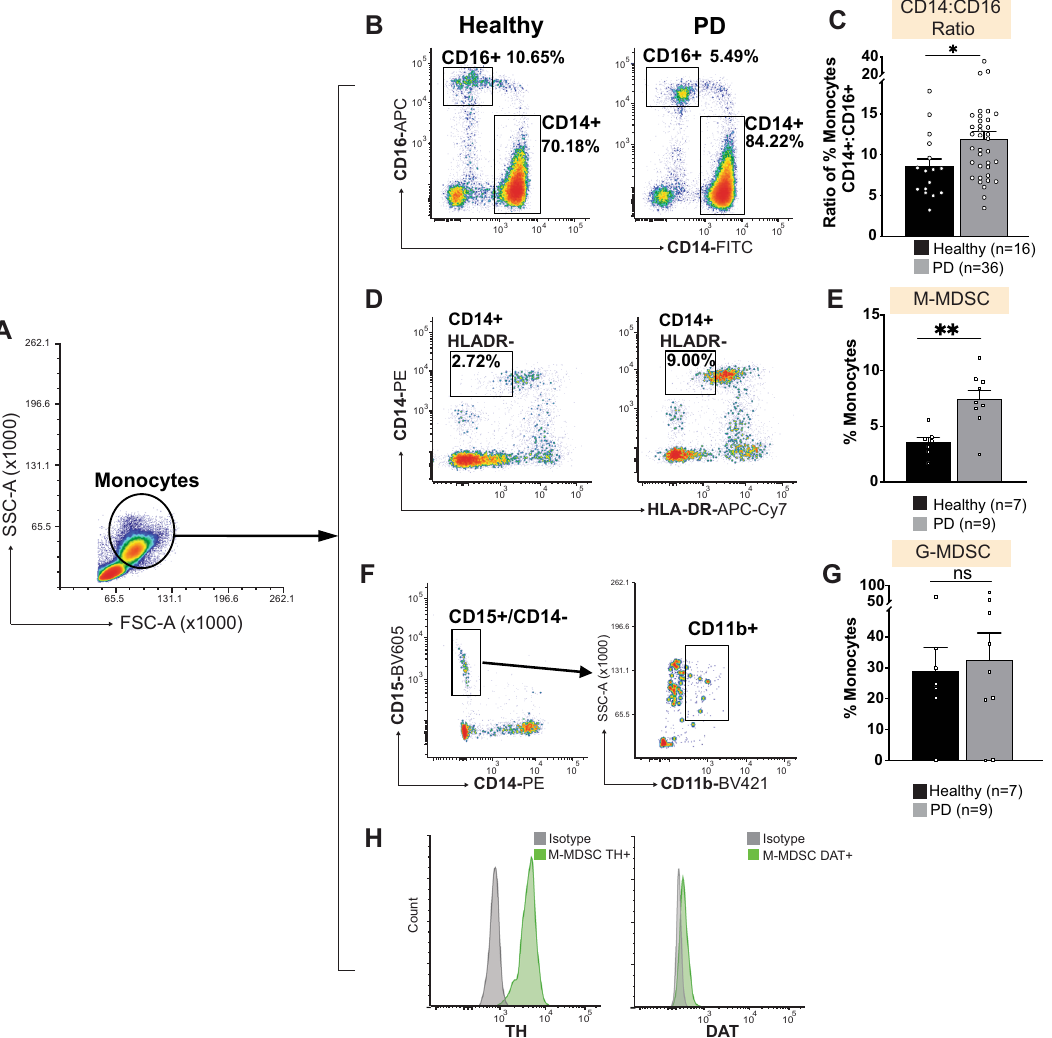
Fig. 1 Parkinson ’ s patient monocytes are polarized towards a CD14 + pro-in fl ammatory phenotype with functional polarization towards monocytic-myeloid derived suppressor cells (M-MDSCs). Monocytes gated by scatter ( A ) were fi rst analyzed for expression of CD14 and CD16 ( B ). Analysis con fi rms signi fi cant polarization of Parkinson ’ s patient monocytes towards the classical CD14 + monocyte phenotype ( C ); two-tailed t -test, p < 0.05. D , E Further immunophenotyping of Parkinson ’ s patient monocytes revealed a signi fi cant increase in the percentage of M-MDSCs characterized by expression of CD14 and absence of HLA-DR ( E – G ), relative to healthy controls. No change was found in granulocytic MDSCs (G- MDSCs) ( F , G ) characterized by expression of CD15 and CD11b. H M-MDSCs express both DAT and TH. Routine metrics such as age distribution, sex distribution, disease duration, treatment, LED score and motor scores, along with statistical analysis are included in Supplementary Tables 1 and 2. All data shown are